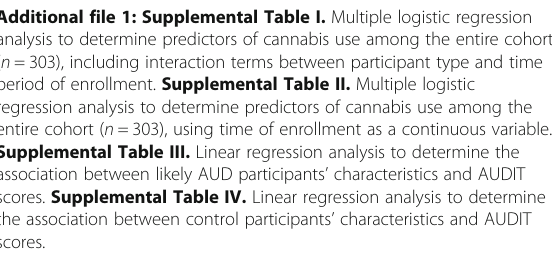
Supplemental Table III. Linear regression analysis to determine the association between likely AUD participants ’ characteristics and AUDIT scores. Supplemental Table IV. Linear regression analysis to determine the association between control participants ’ characteristics and AUDIT